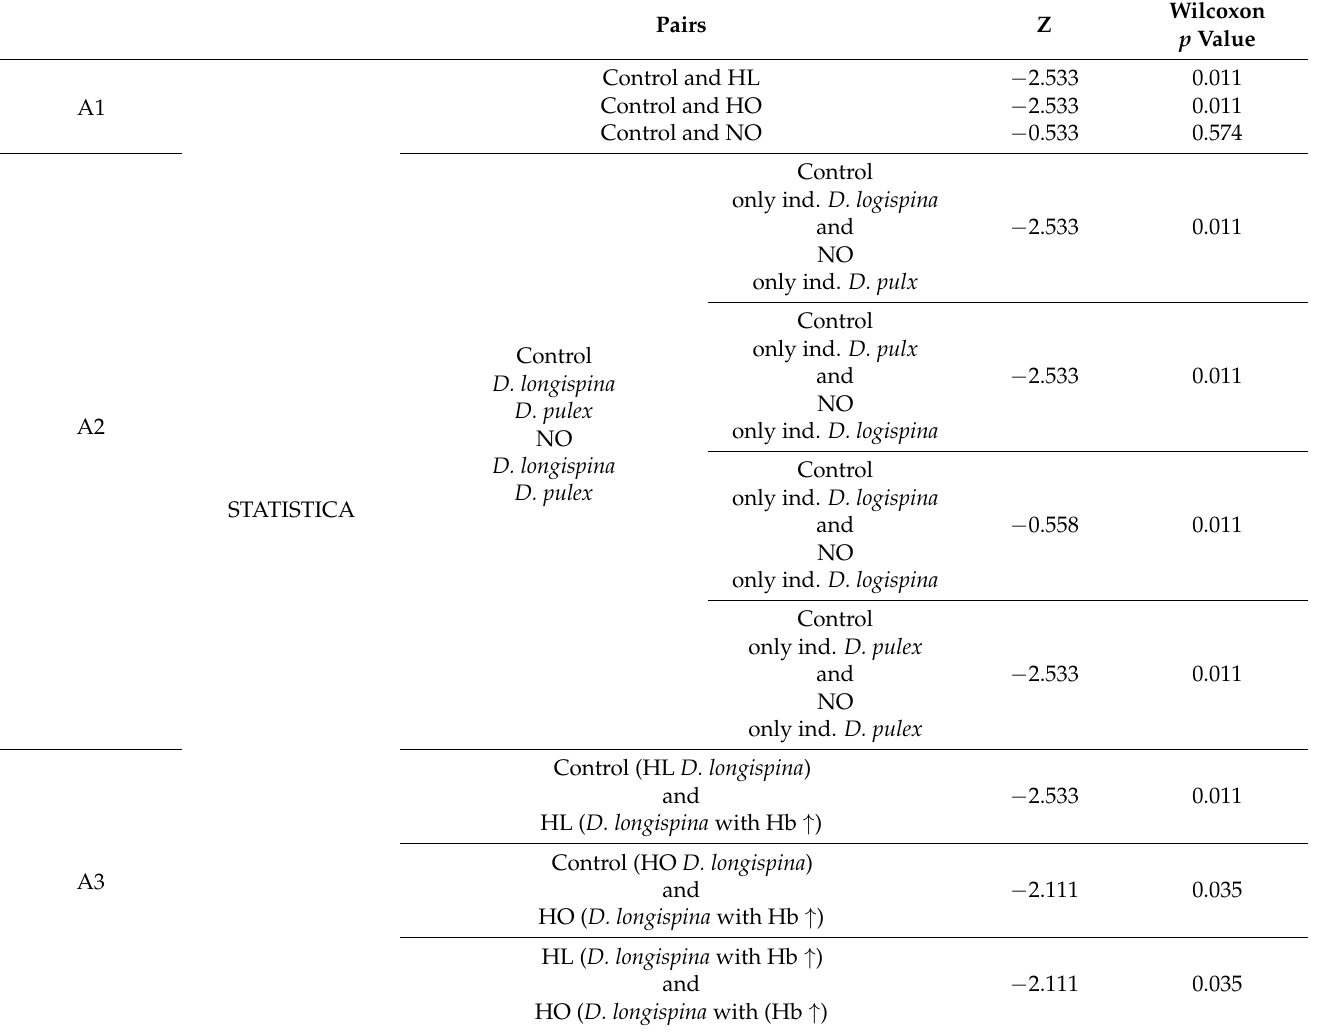
Table 2. Results of the Wilcoxon test for Hypotheses 1, 2,